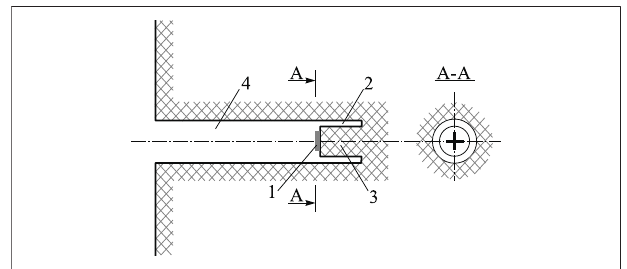
FIGURE 3 | Stresses measurement scheme: 1, strain gauge; 2, annular slot; 3, core; 4,